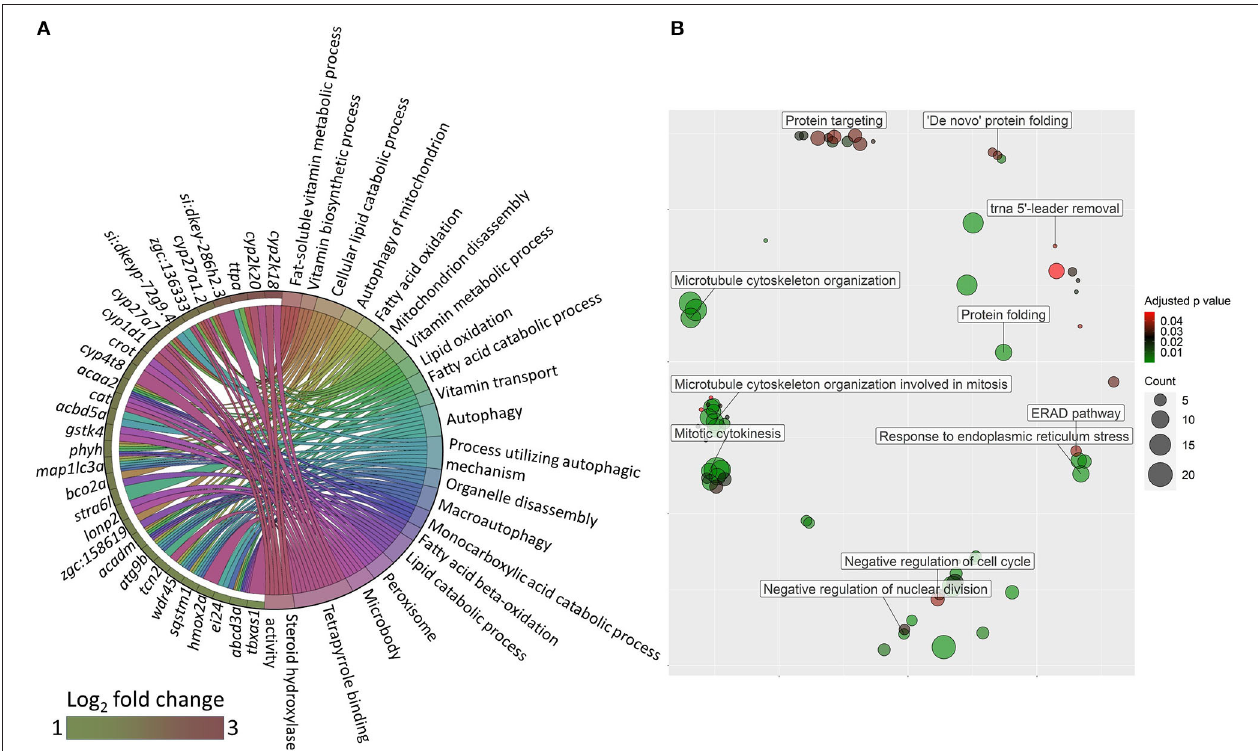
FIGURE 6 | GO terms that were altered in zebrafish fed the oat glucan diet. (A) Chord diagram showing the link between enriched GO terms and the associated upregulated genes in the oat glucan (OG) group compared to the high cholesterol diet (HC) group. Genes that were considered for the enrichment are shown on the left half of the circle. The gradient color bar intensity varies with the Log 2 fold change. (B) Enriched GO terms in the OG group. Only the non-redundant GO terms are marked in the bubble plot, and the analysis was performed using the genes that were downregulated in the OG group compared to the HC group. The color of the circles ranging from green to red indicates the order of adjusted p value (0.01–0.049). Circle sizes are proportional to the gene count.